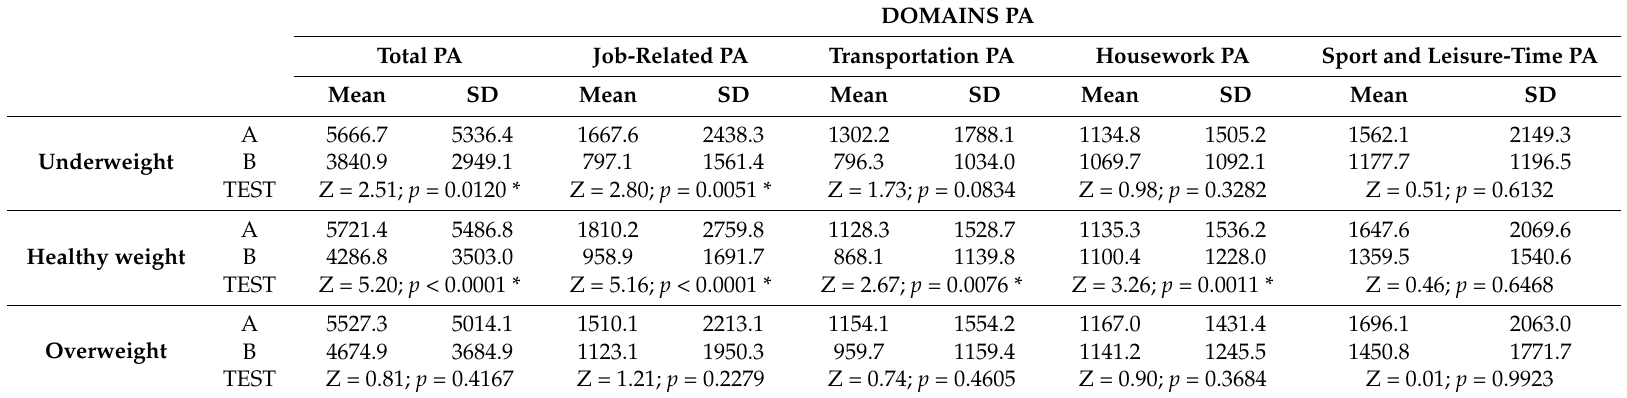
Table 4. Level of total activity and its domains by BMI in various countries